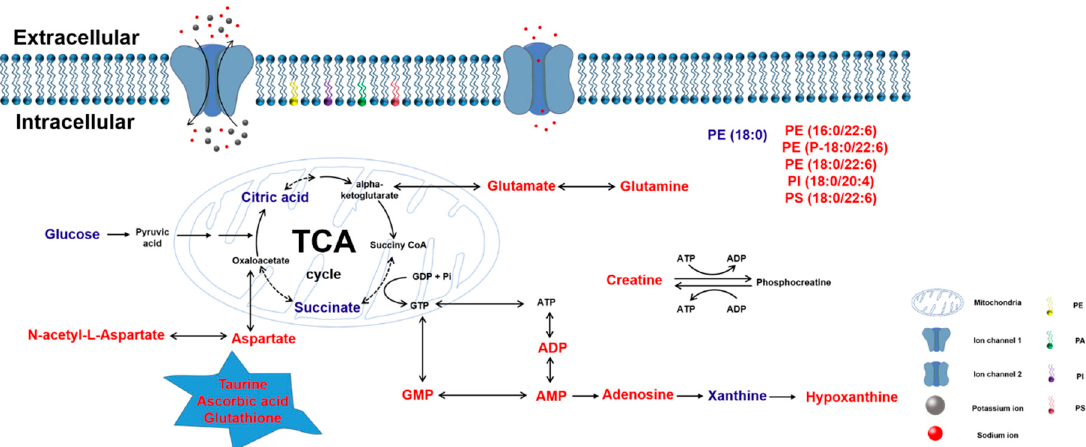
Figure 8. Summary of changes in endogenous small molecules as detected by MALDI-MSI. Small molecules that were significantly increased in ischemia-damaged regions after thymoquinone administration are represented in red; those that were significantly decreased are represented in blue.